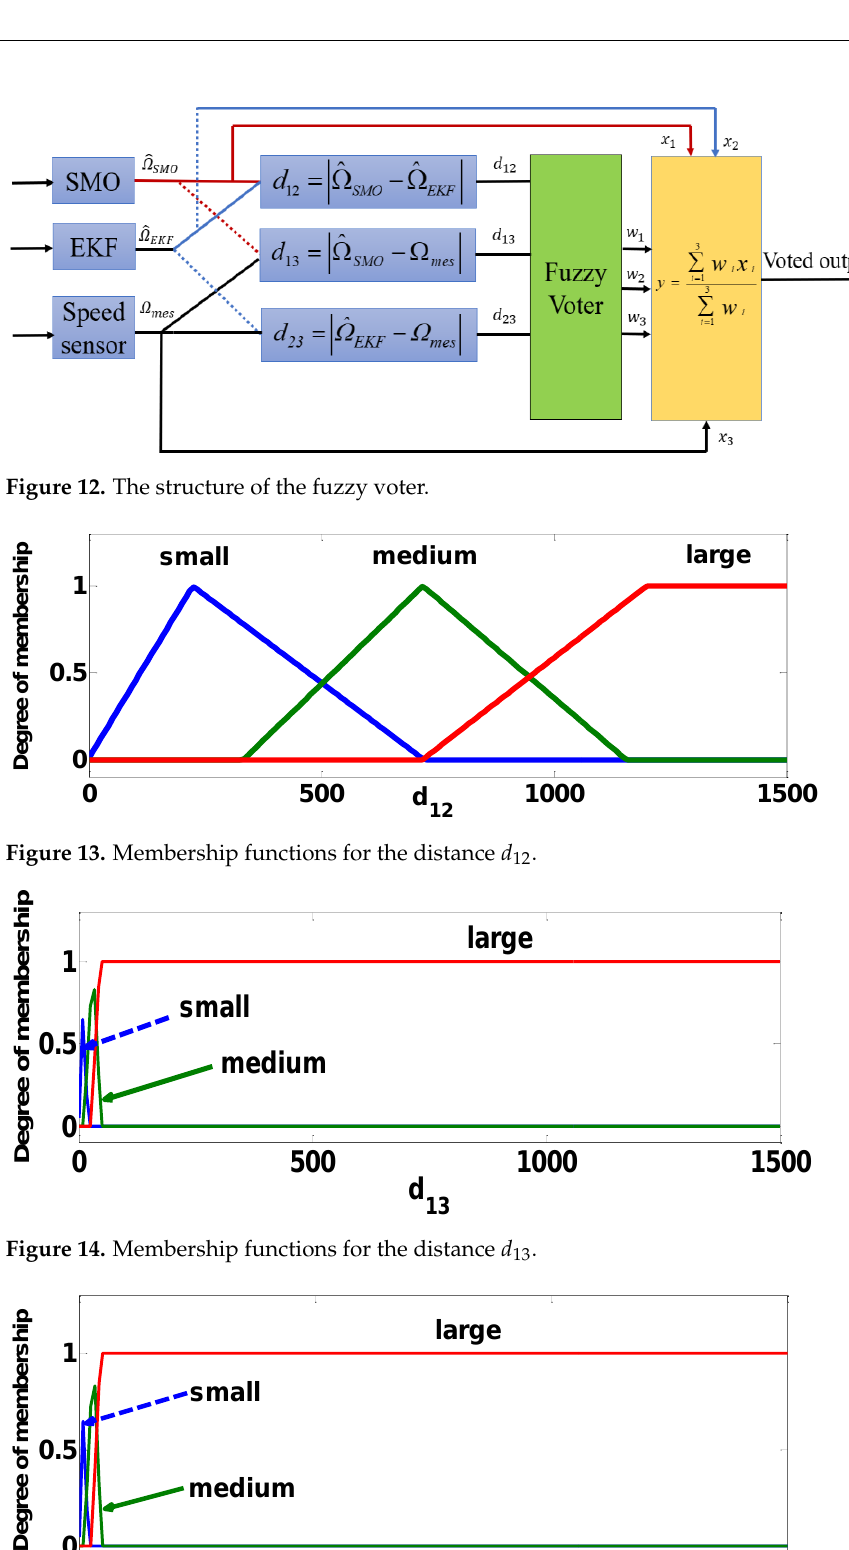
14 of 20 Figure 11. The structure of the multilayer feed-forward back-propagation neural network. 4.2. Fuzzy Voter Algorithm